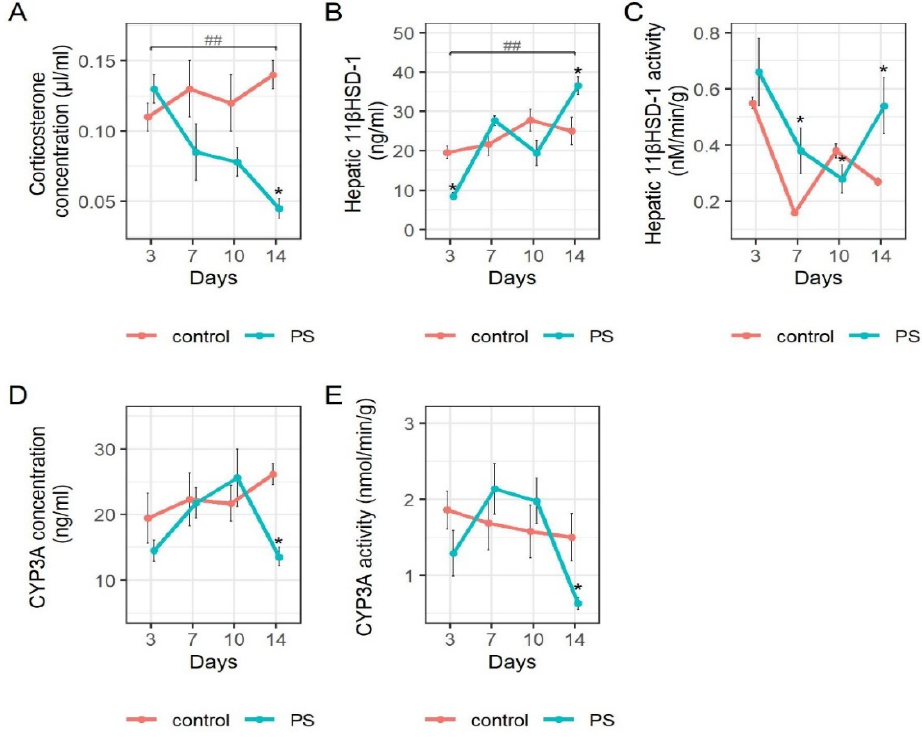
Figure 3. The impact of post-stress time on plasma corticosterone concentrations and on glucocorti- coid-metabolizing enzymes protein concentration and activity in the liver. Mann–Whitney compar- isons of M ± SD for ( A ) plasma corticosterone concentration, ( B ) hepatic 11 β HSD1 protein concen- tration, ( C ) hepatic 11 β HSD1 activity, ( D ) hepatic CYP3A protein concentration, ( E ) hepatic CYP3A activity. * p < 0.05 for differences between means of respective control and PS groups. ## p < 0.01 for differences between means of PS group at post-stress days 3 and